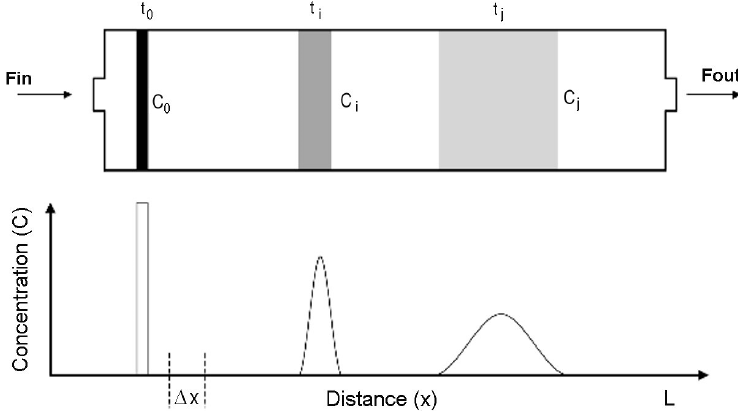
Figure 8. Diagram representing the diffusion effect respect time and space (not at scale) in the tank for a water inflow Fin . At different instant times (t 0 , t i , t j …), the concentration of chlorine is different in the tank ( c 0 , c i , c j …) depending on the distance to the tank inlet (function of x ).